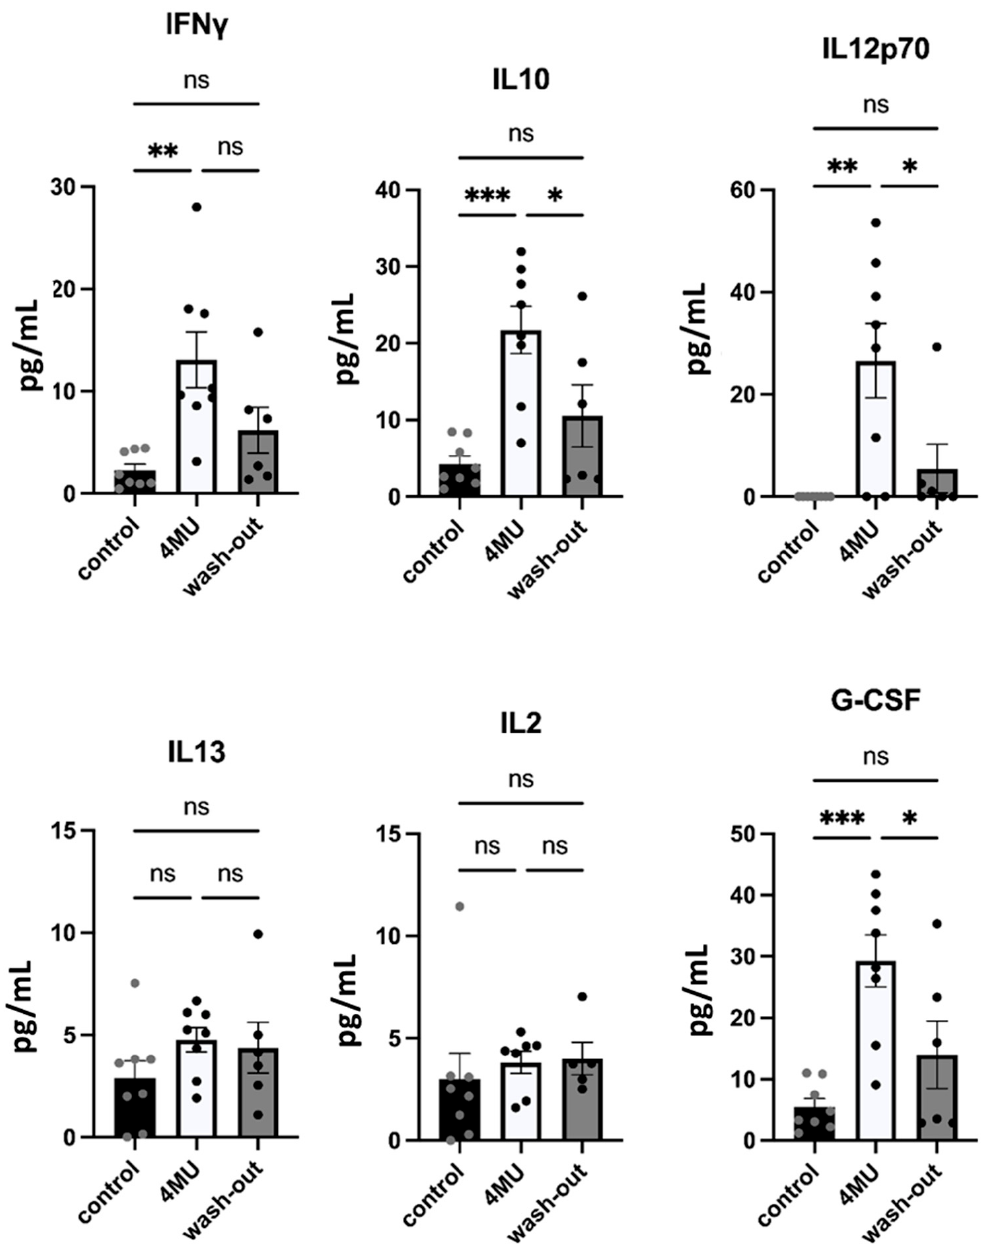
Figure 6. Serological levels of cytokines and interleukins after long-term 4MU treatment. Bar graphs show the level of detected cytokines and interleukins. Data are expressed as a mean ± SEM; * p < 0.05, ** p < 0.01, *** p < 0.001 by one-way ANOVA with Tukey’s multiple comparisons test, n = 5–8. ns: no